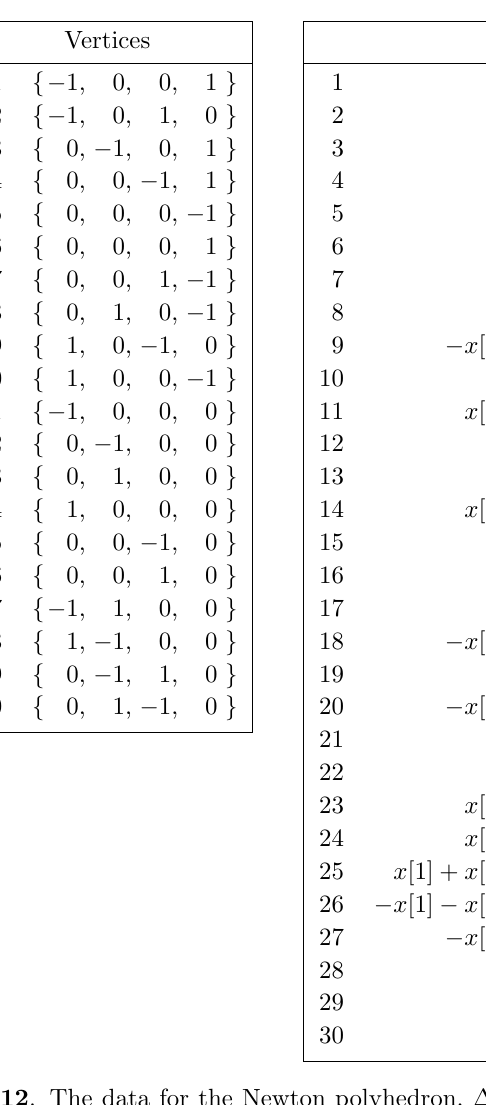
Table 12 . The data for the Newton polyhedron, (cid:1). The (cid:12)rst table lists the vertices of (cid:1), while the second lists the three-faces. The lists on the right of the second table give the vertices of the corresponding